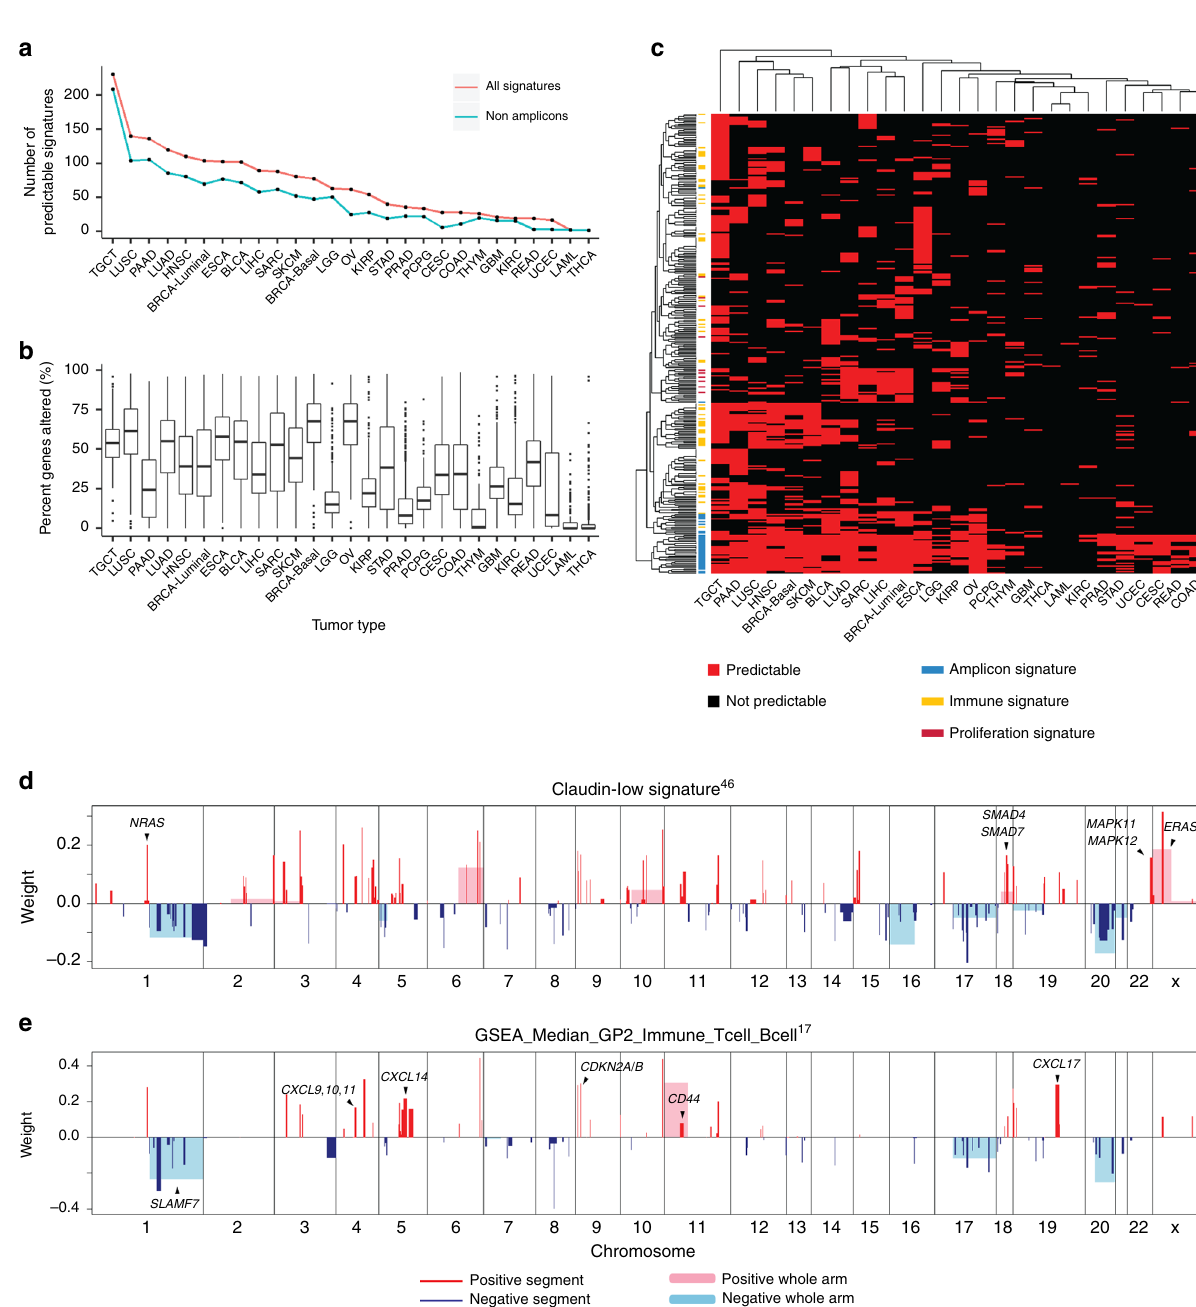
Fig. 6 Pan-cancer DNA copy number alteration-based Elastic Net models for gene signatures. a Line plots indicate the number of highly predictable signatures (i.e., AUC > 0.75) (red) and highly predictable non-amplicon signatures (green) in each tumor type. b Box and whisker plots indicating the median score (horizontal line), the interquartile range (IQR, box boundaries) and 1.5 times the IQR (whiskers) of the percentage of copy number altered genes in each tumor type. c Heatmap shows the predictability of each gene signature in each tumor type. Red indicates predictable and black indicates not predictable. Tumors and gene signatures are clustered by hierarchical clustering using Euclidean distance and complete linkage. d , e Selected CNA segments and/or whole chromosomal arms and their coef fi cients of the multi-tumor prediction model for Claudin-low signature ( d ) and immune signature ( e